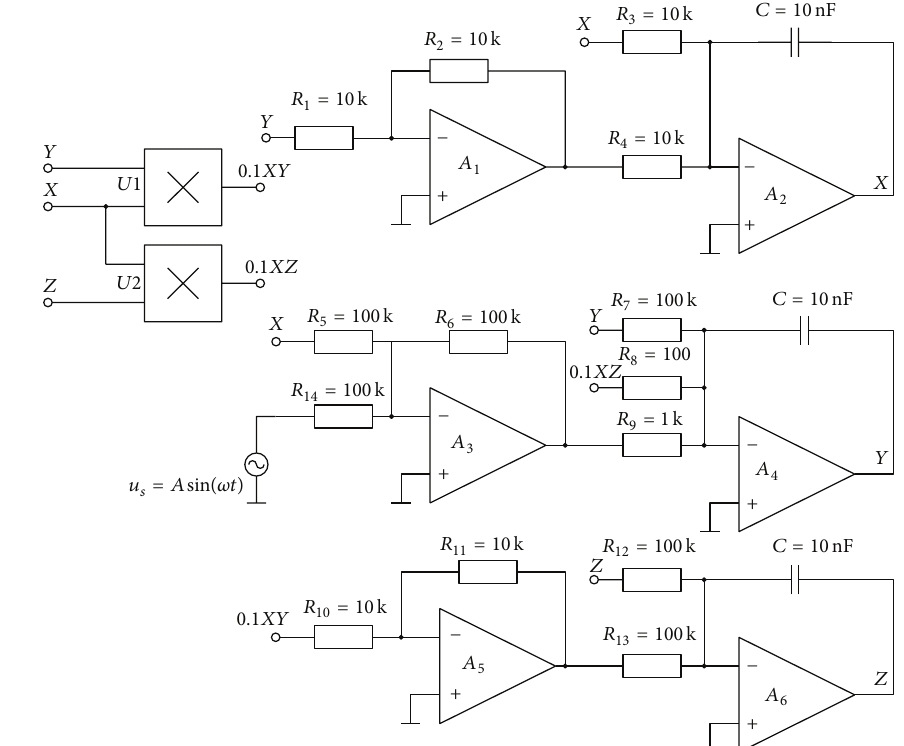
Figure 9: Circuit implementation of the system